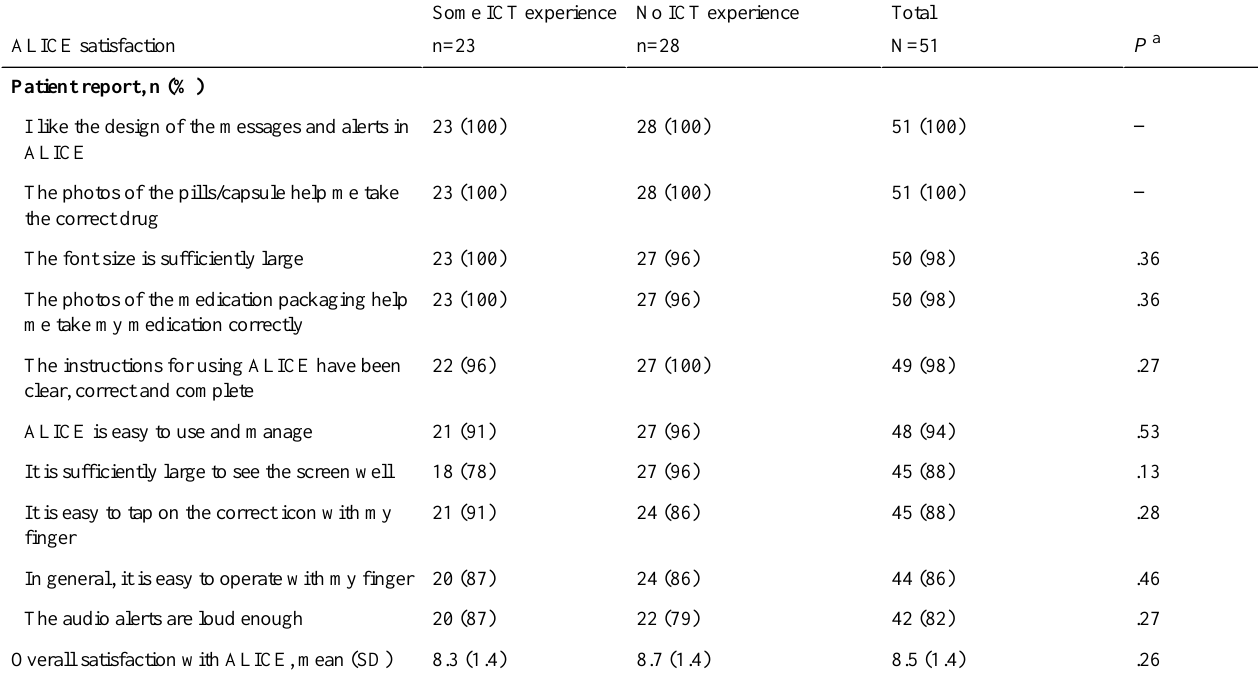
Table 5. Patient satisfaction with ALICE